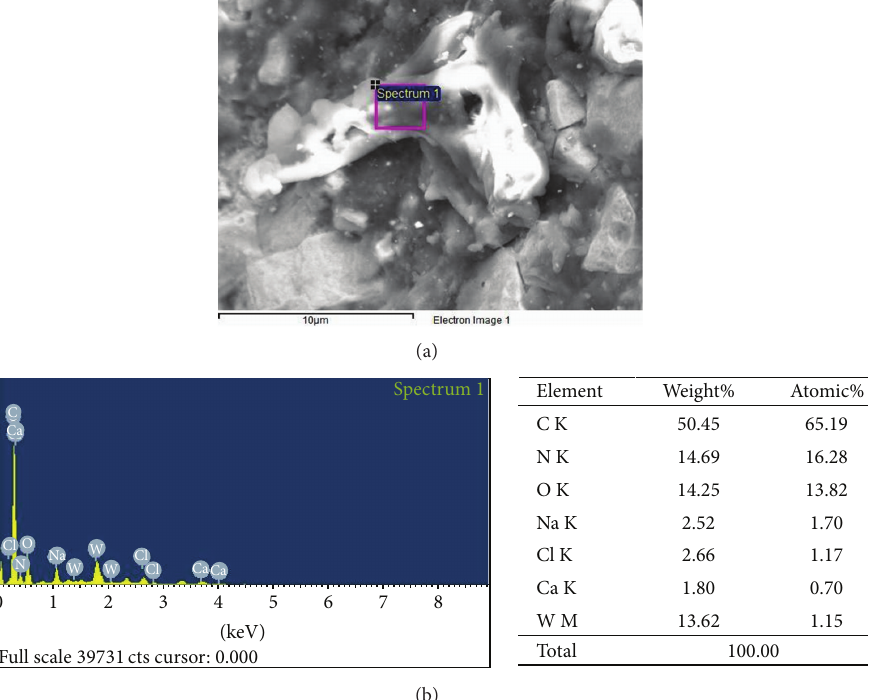
Figure 9: Adhering of rock particle; EDS spectra showing the concentration of elements.